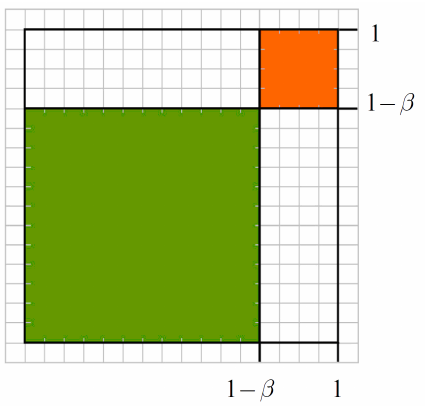
Figure 2: Shape of the support of the underlying patchwork copula W